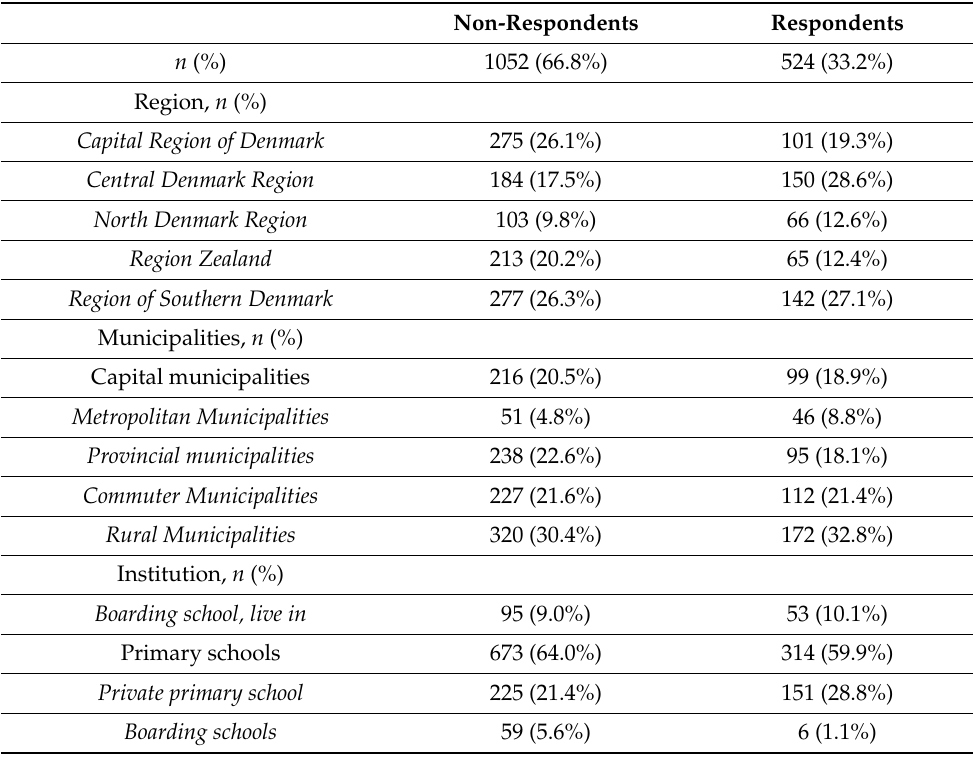
Table 2. Analysis of non-respondents stratified on region, municipality, and institution, n = 2129.